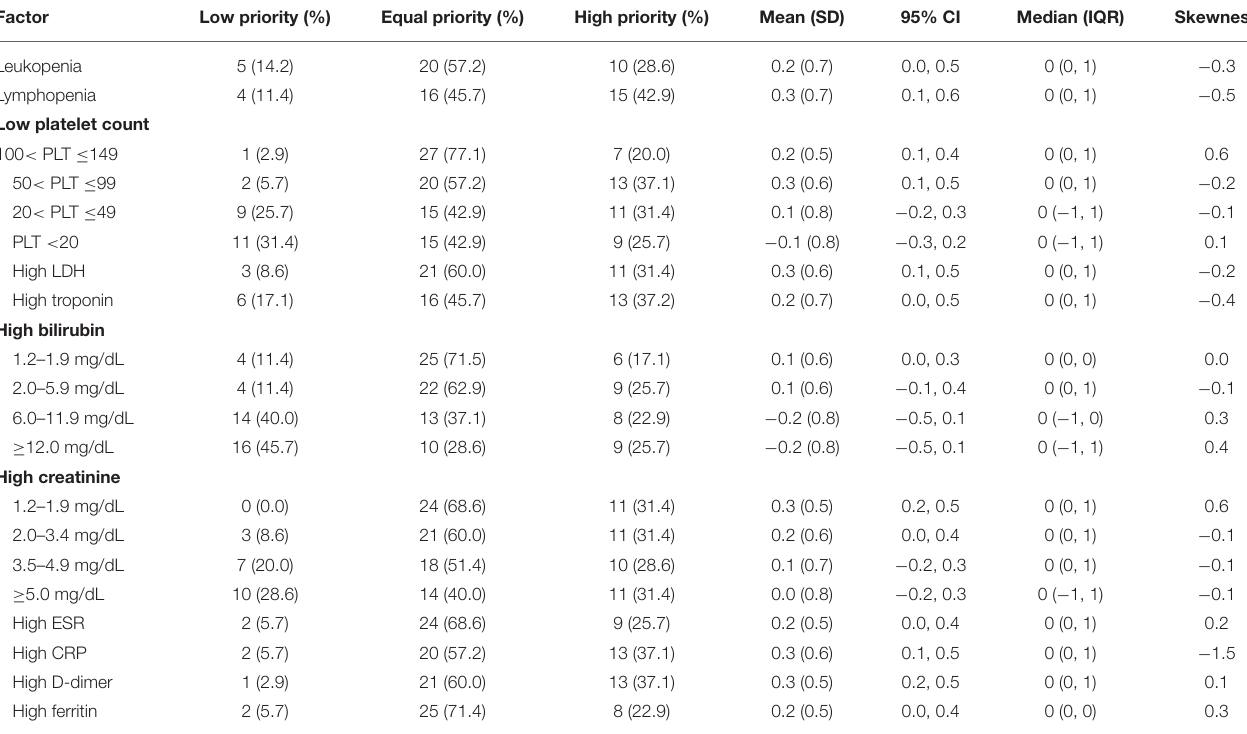
TABLE 5 | Responses on prioritising ventilator allocation regarding laboratory presentation of COVID-19.